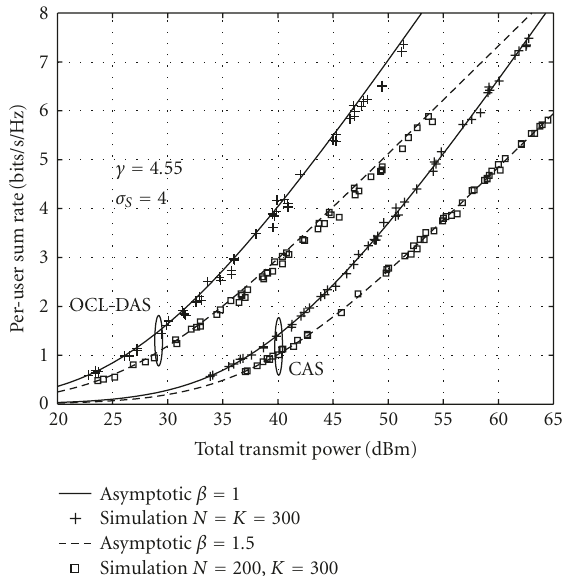
Figure 4: Simulation results for a large-scale system with γ = 4 . 55.